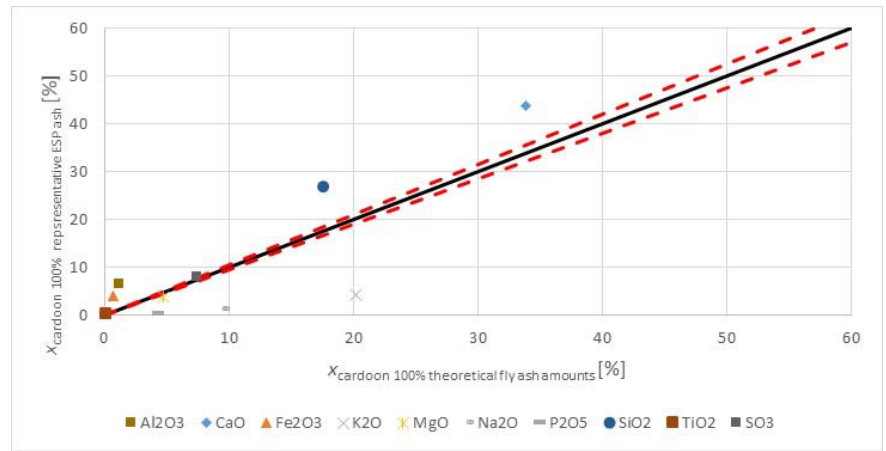
Figure 12. Enrichment of elements in the fly ash for 100% thermal share of Cynara; fuel ash plotted on the abscissa and representative ESP ash plotted on the ordinate; dashed lines estimate the uncertainty due to analyses variability (±5%).